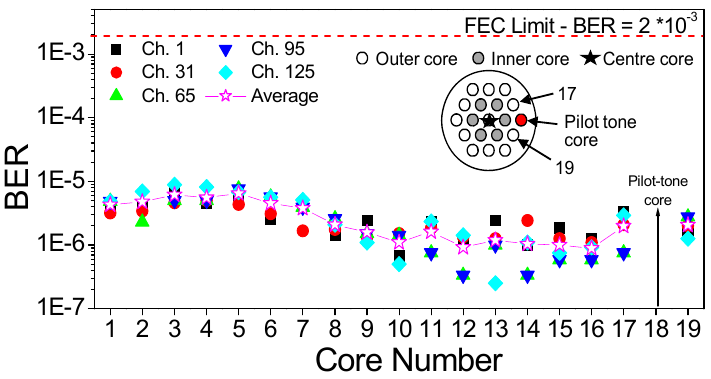
Figure 8. Measured BER in each signal core for five channels with equally spaced optical frequencies ranging from 195.3 THz (Ch. 1) to 189.1 THz (Ch.